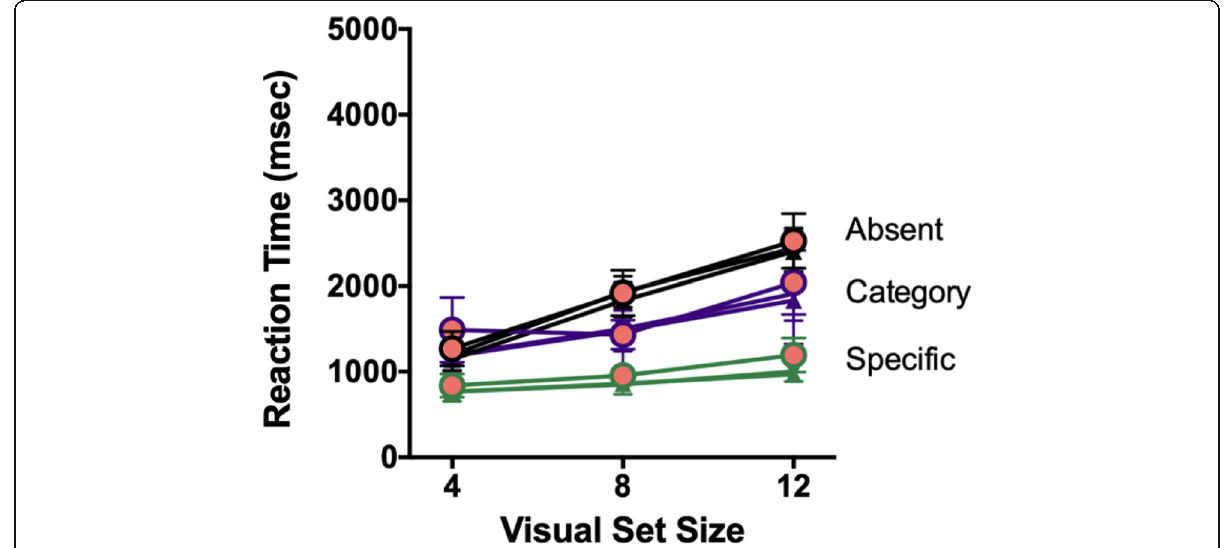
Fig. 4 Reaction time (RT) x VSS functions for Experiment 1b for all search trials, averaged across the 3 blocks. Solid symbols are the non-boosted trials from Blocks 1 and 3. Large red-filled circles highlight the non-boosted trials from Block 2. RTs do not vary systematically with block. Error bars are ± 1